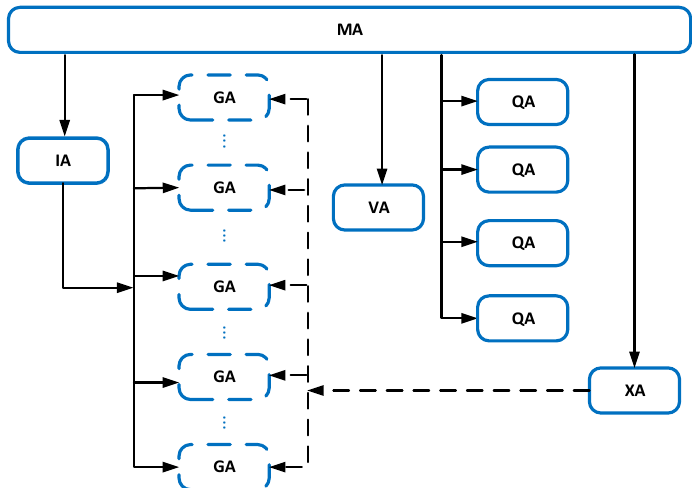
Figure 6. Basic agent architecture and agent relationships. (Solid lines show agents’ constructions and dashed lines show their destructions. Solid ovals show agents which exist permanently and dashed ovals show agents which exist temporarily in the